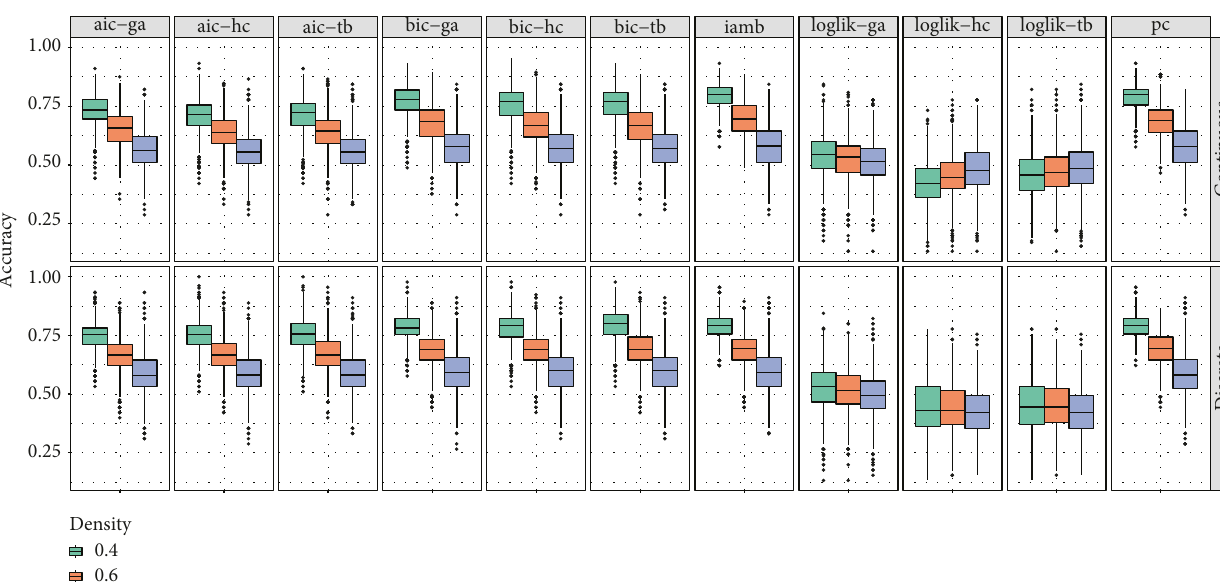
Figure 2: Boxplots showing the accuracy of the results obtained by the 11 tests approaches on the discrete and continuous datasets. In the fi gure, conditional boxplot in each subpanel reports results for structure of density 0.4, 0.6, and 0 . 8 from left to